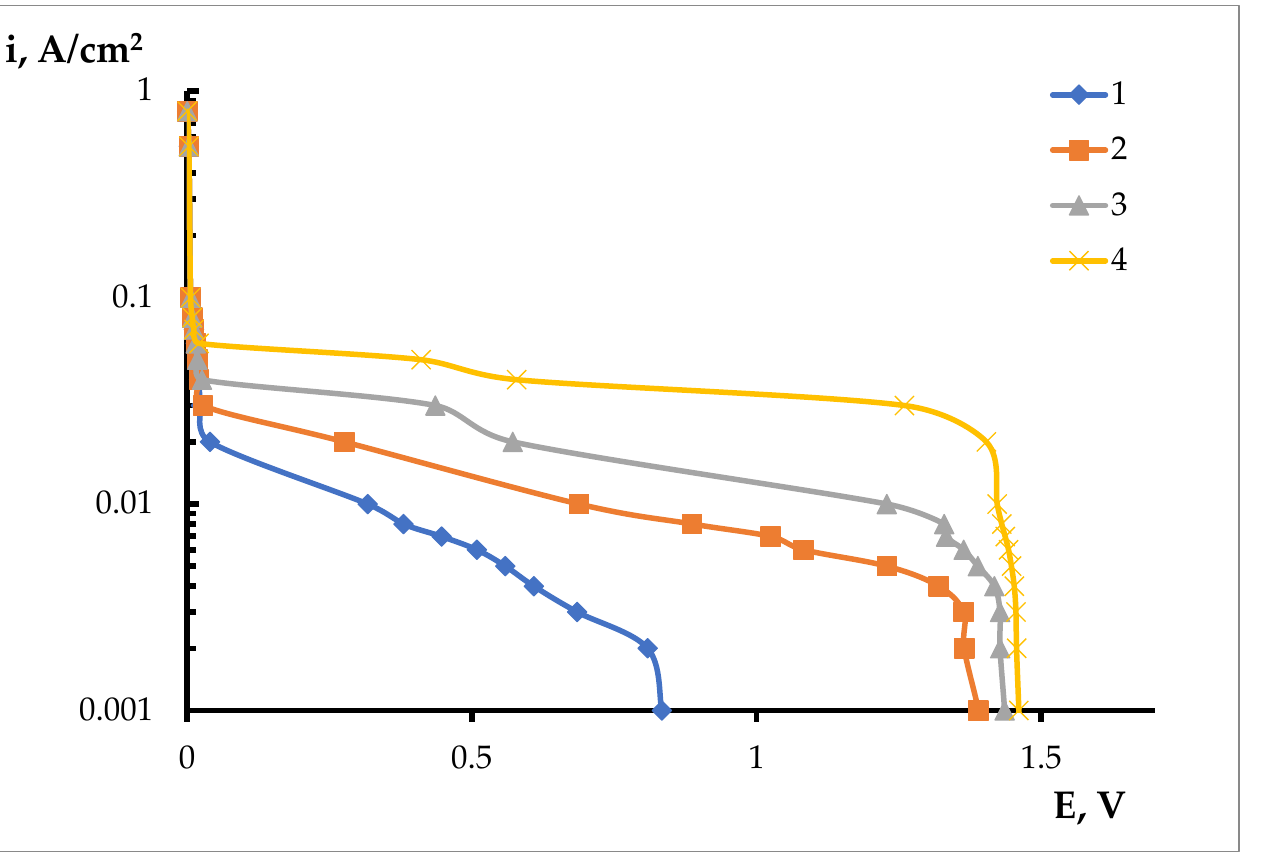
Figure 5. Cathode polarization of iron electrodes relative to the beryllium reference electrodes at a temperature of 923 K in the 0.66LiF – 0.34BeF 2 melt. The iron concentration, wt.%: 1 — 0.0031; 2 — 0.0338; 3 — 0.0651; 4 — 0.0992.